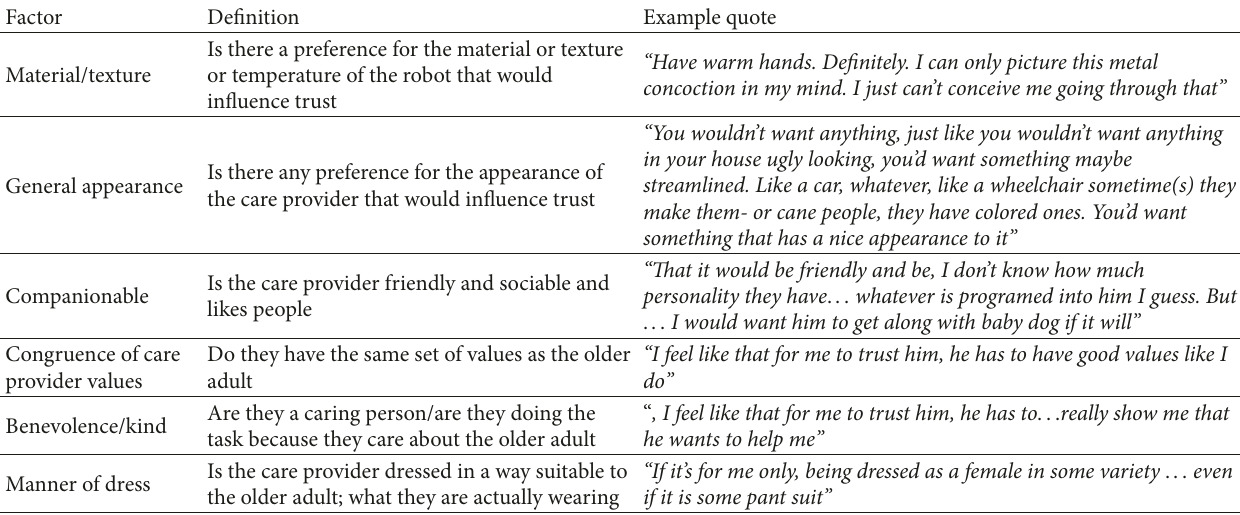
Table 6: Personal traits: definitions and examples of